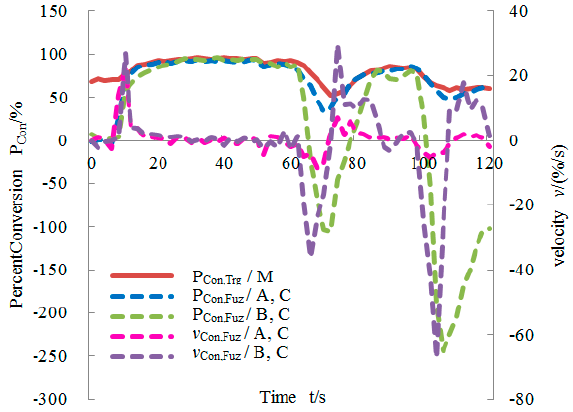
Figure 12. Conversion efficiency and its velocity before and after correction.